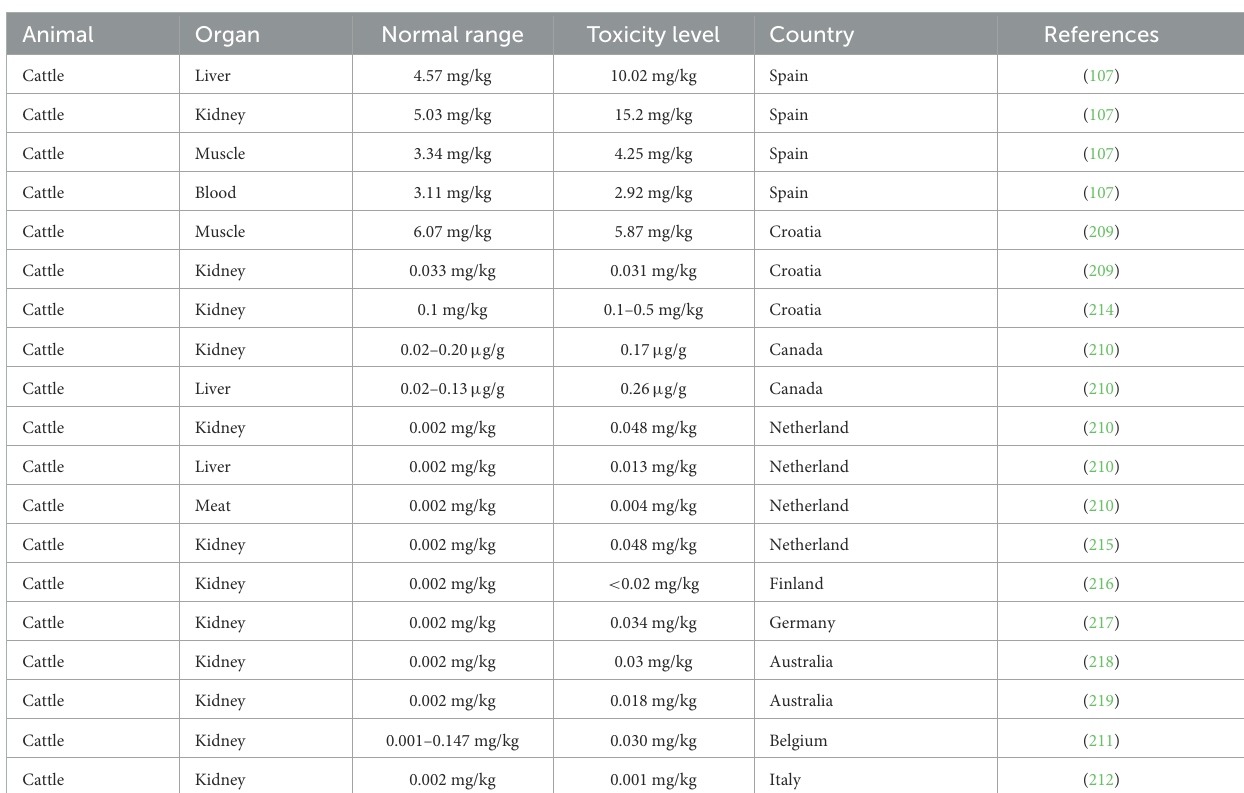
TABLE 2 Arsenic toxicity observed in different organs of cattle.